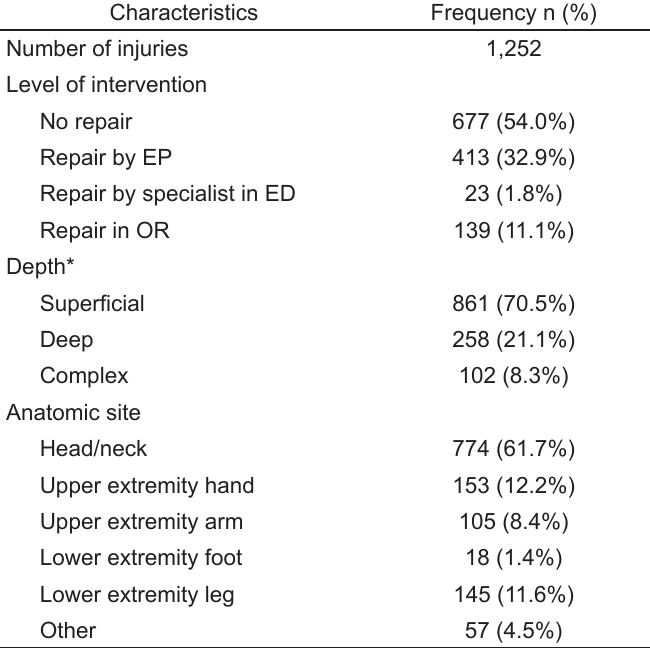
Table 2. Characteristics of dog-bite